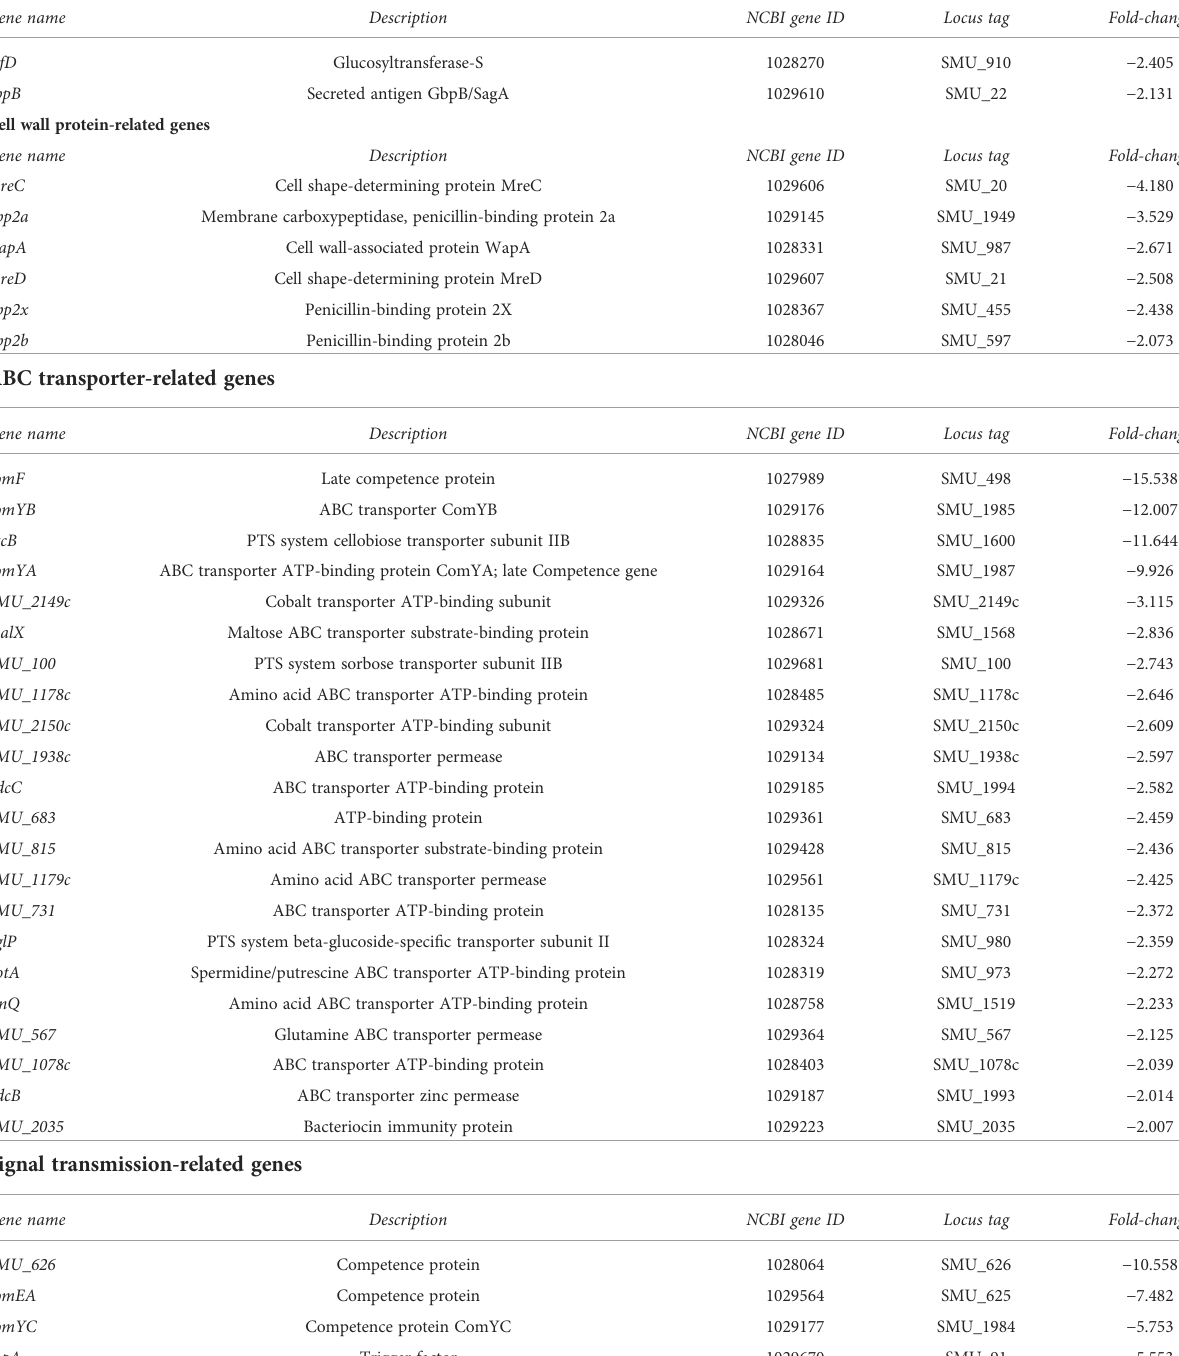
TABLE 4 List of genes whose expression was downregulated (>2-fold) in strain SN74CND compared with parental strain SN74 by RNA- Sequencing. Cell surface protein-related